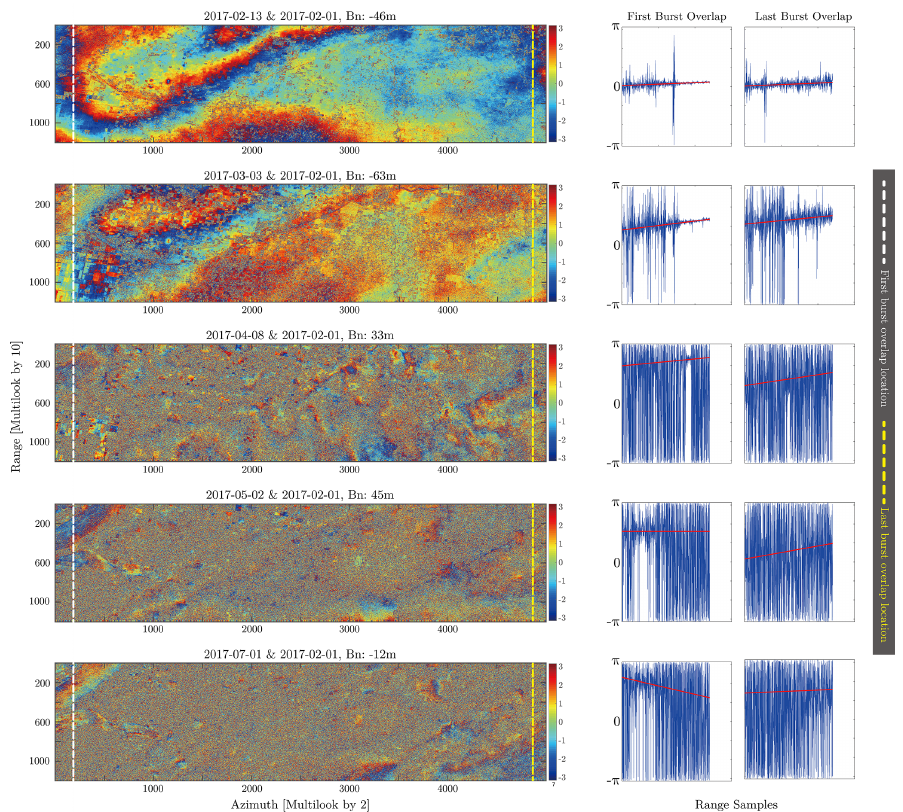
Figure 9. The test case in the California Central Valley. The interferograms are from the proposed approach. From top to bottom, the temporal baselines are 12, 30, 60, 90 and 150 days. For each data, the first burst overlap area (location showed in white dash line) and the last burst overlap area (in yellow dash line) are shown as example. The test site has 12,000 range samples and 10,000 azimuth lines. The interferograms are multilooked 10 (range) by 2 (azimuth). No additional filter is